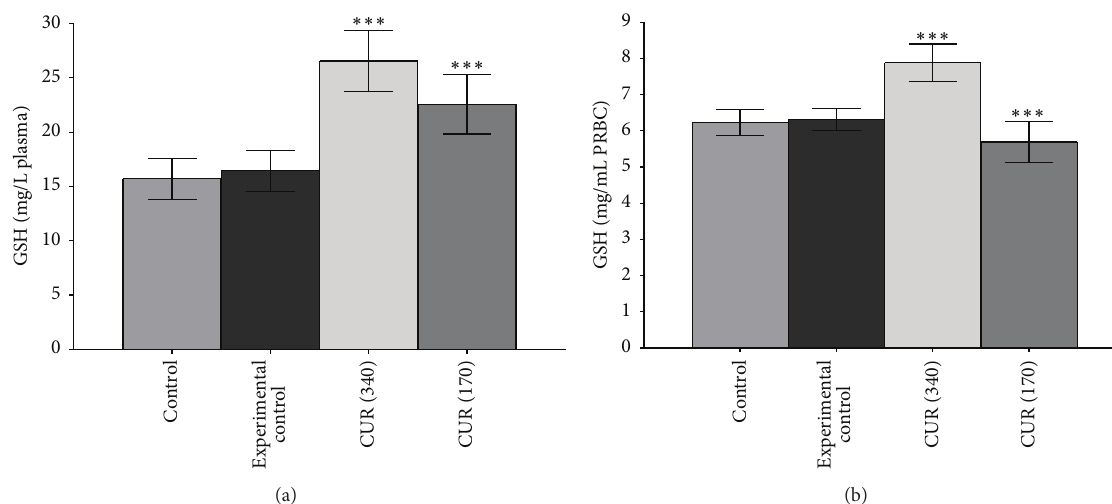
Figure 7: In vivo effect of curcumin (340 mg/kg b.w. as CUR 340 and 170mg/kg b.w. oral CUR 170) on GSH concentration in rats (a) plasma and (b) erythrocytes. Concentration of GSH is expressed in 𝜇 g/mL plasma and mg/mL PRBCs. Values represent mean ± SD. Control represents rats receiving no treatment/supplementation; experimental control: rats were supplemented with 0.9% NaCl solution through oral route.